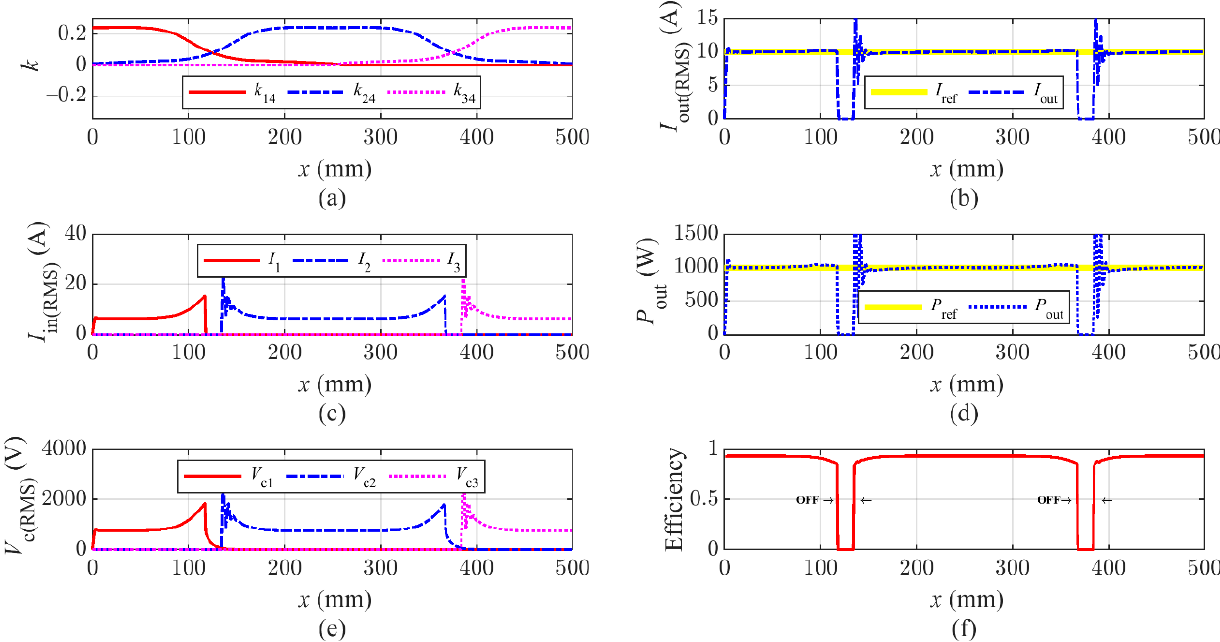
Figure 12. Third solution: ( a ) coupling coefficients k 14 , k 24 and k 34 ; ( b ) output current I out(RMS) ; ( c ) input currents I 1(RMS) , I 2(RMS) and I 3(RMS) ; ( d ) output power P out(RMS) ; ( e ) voltages on a primary side capacitor V c 1(RMS) , V c 2(RMS) and V c 3(RMS) ; ( f ) system efficiency.